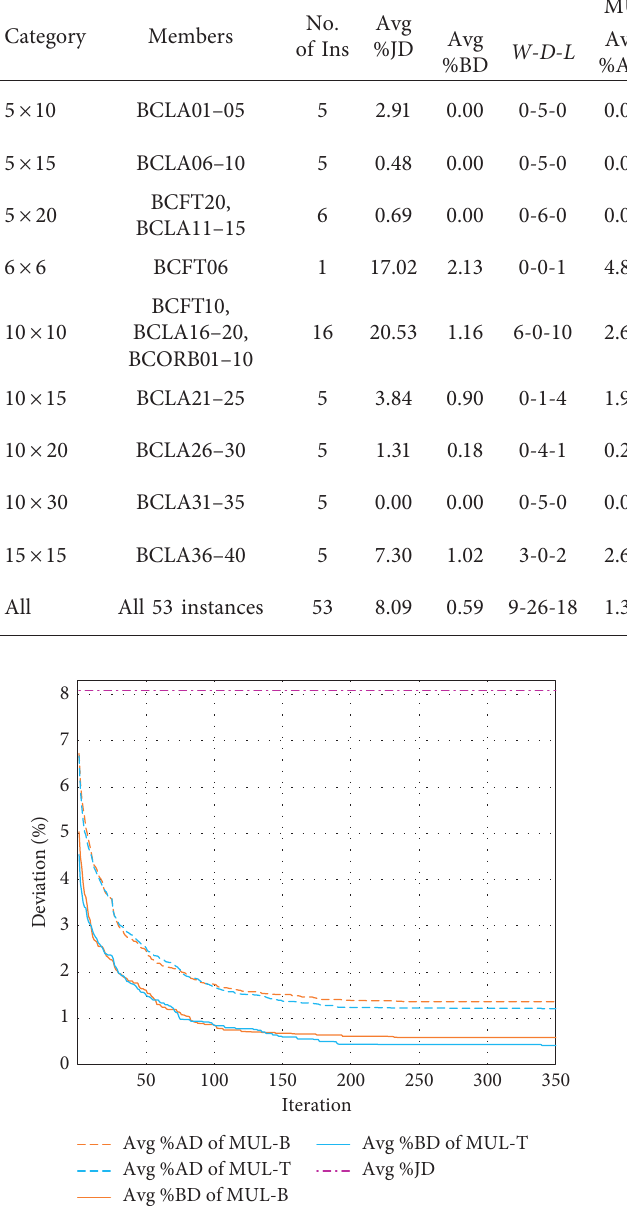
Figure 5: Avg %ADs and Avg %BDs over iterations of MUL-B and MUL-T compared with Avg